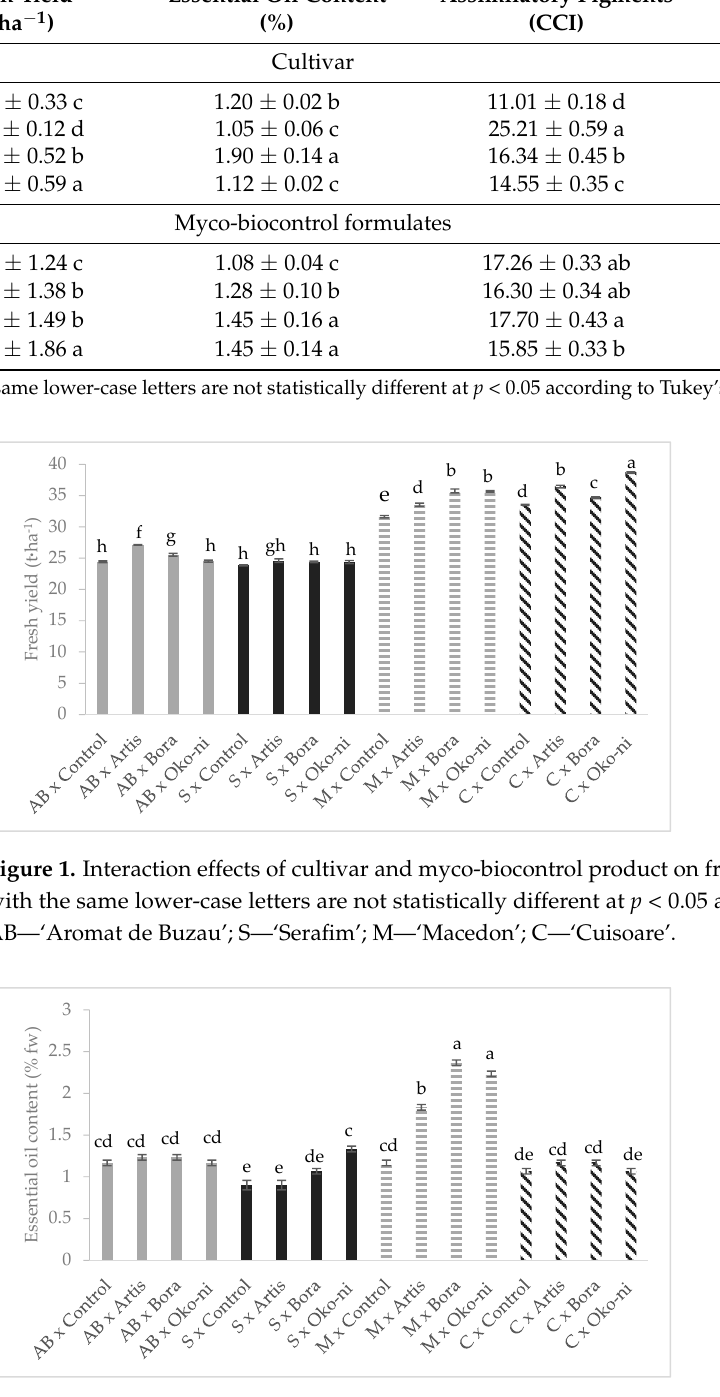
Figure 3. Interaction effects of cultivar and myco-biocontrol formulate on assimilatory pigments of basil. Values with the same lower-case letters are not statistically different at p < 0.05 according to Tukey’s test. AB—‘Aromat de Buzau’; S—‘Serafim’; M—‘Macedon’; C—‘Cuisoare’.